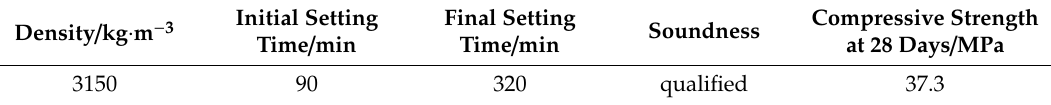
Table 1. Chemical compositions (by mass) and basic physical properties of cement.